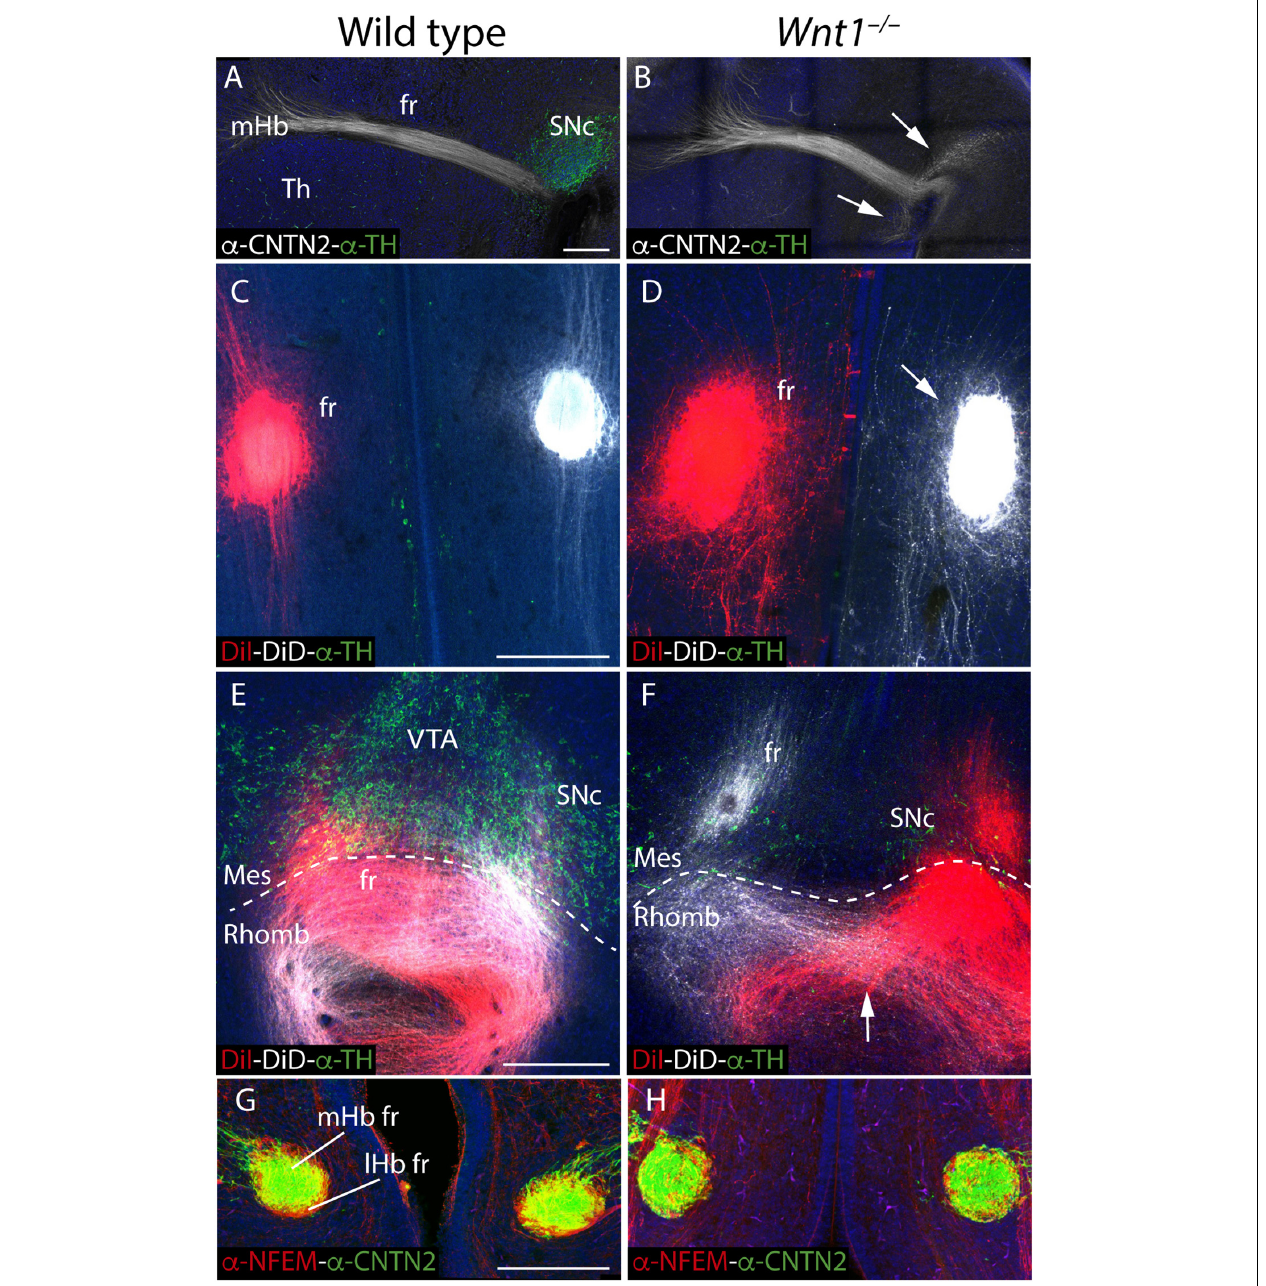
FIGURE 5 | Study of the fr phenotype in Wnt1 − / − mutant. E15.5 wt (A) and Wnt1 − / − brain sagittal sections (B) stained against CNTN2 (mHb marker; white) and TH (green). DiI (right fr; red) and DiD (left fr; white) labeling and TH immunofluorescence (green) in coronal sections of an E15.5 wt (C,E) and Wnt1 − / − mutant brain (D,F) at two different levels. Coronal sections of an E15.5 wt (G) and Wnt1 − / − mutant brain (H) , stained with NFEM (as lHb marker; red) and CNTN2 (as mHb marker; green). The arrow in (B) indicates the aberrant axonal navigation. The arrow in (D) indicates the abnormal fr shape. The arrow in (F) indicates the abnormal cross of the floor plate. The dashed line labels the mid-hindbrain boundary. Four samples of each genotype have been analyzed. fr, fasciculus retroflexus; lHb lateral habenula; lHb fr, lateral habenular axons of the fasciculus retroflexus; Mes, mesencephalon; mHb, medial habenula; mHb fr, medial habenular axons of the fasciculus retroflexus; Rhomb, rhombencephalon; SNc, substantia nigra pars compacta Th, thalamus; VTA, Ventral tegmental area. Scale bar: 200 µ